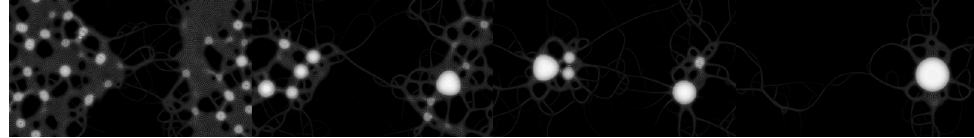
Figure 2: The final movement of Dismantling